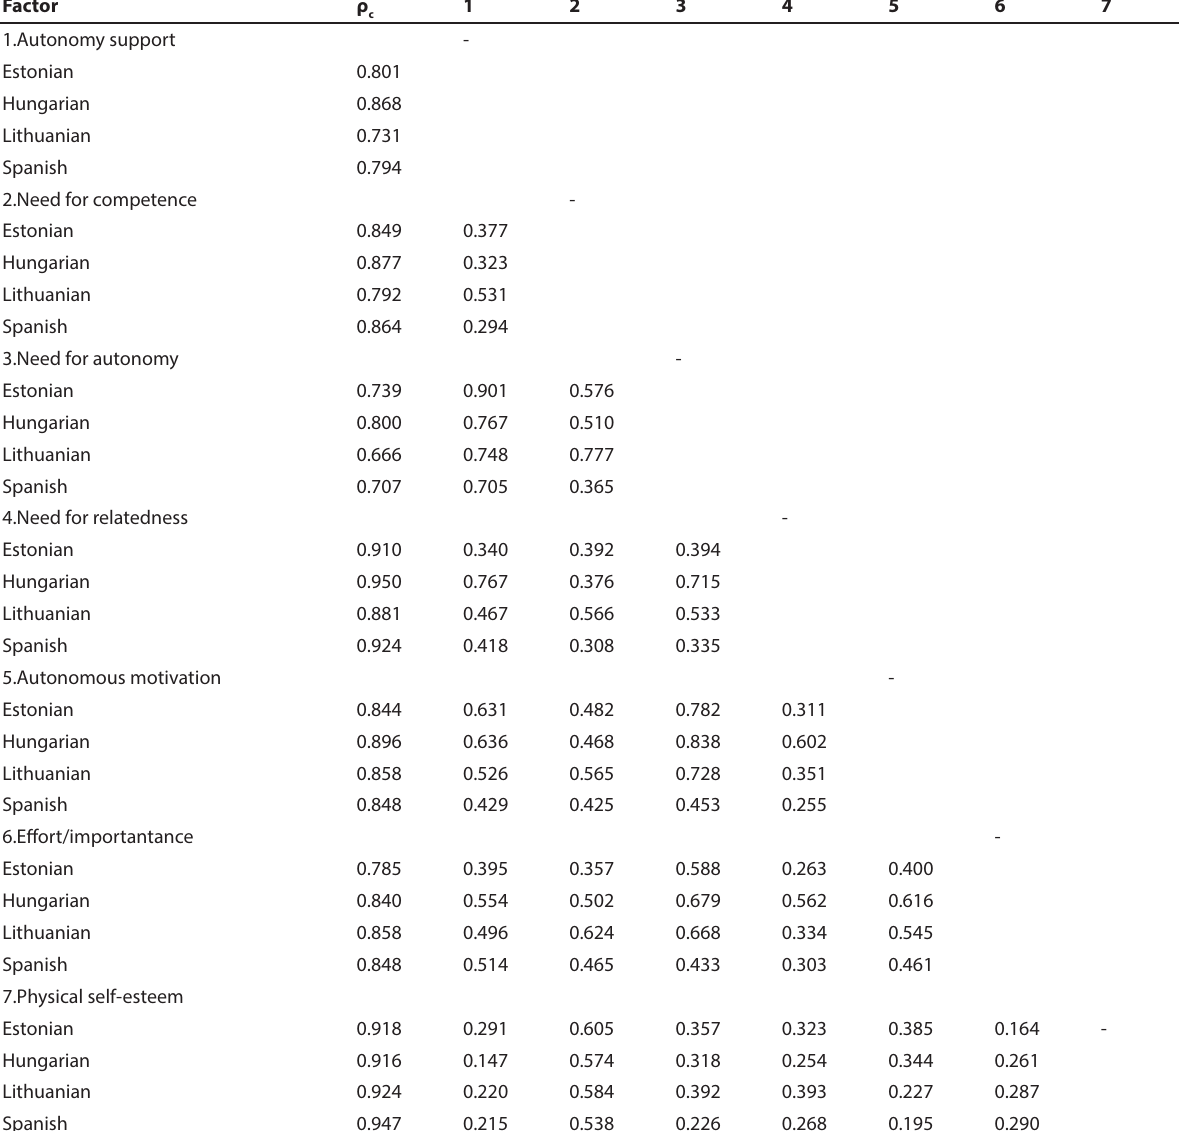
TABLE 2 Factor Correlations for the Latent Factors from the Confirmatory Factor Analysis of the Measurement Model